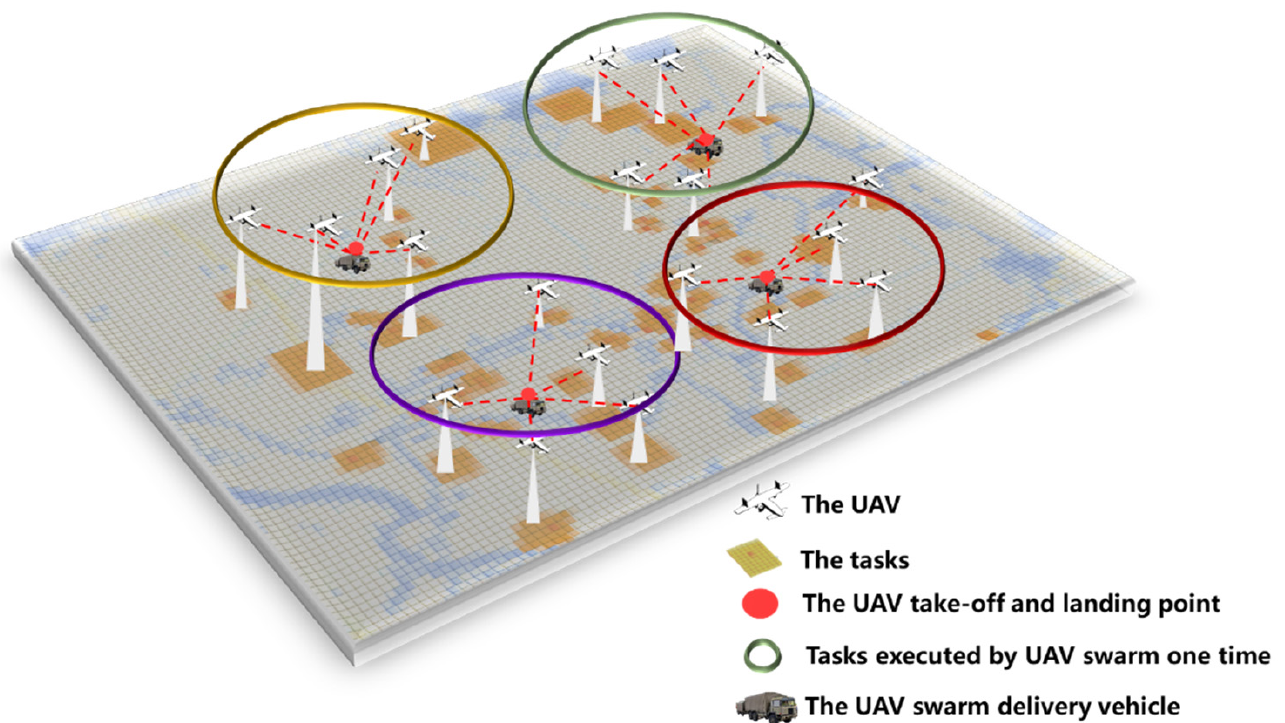
Figure 1. Visual representation of UAV swarm scheduling for emergency scenarios.